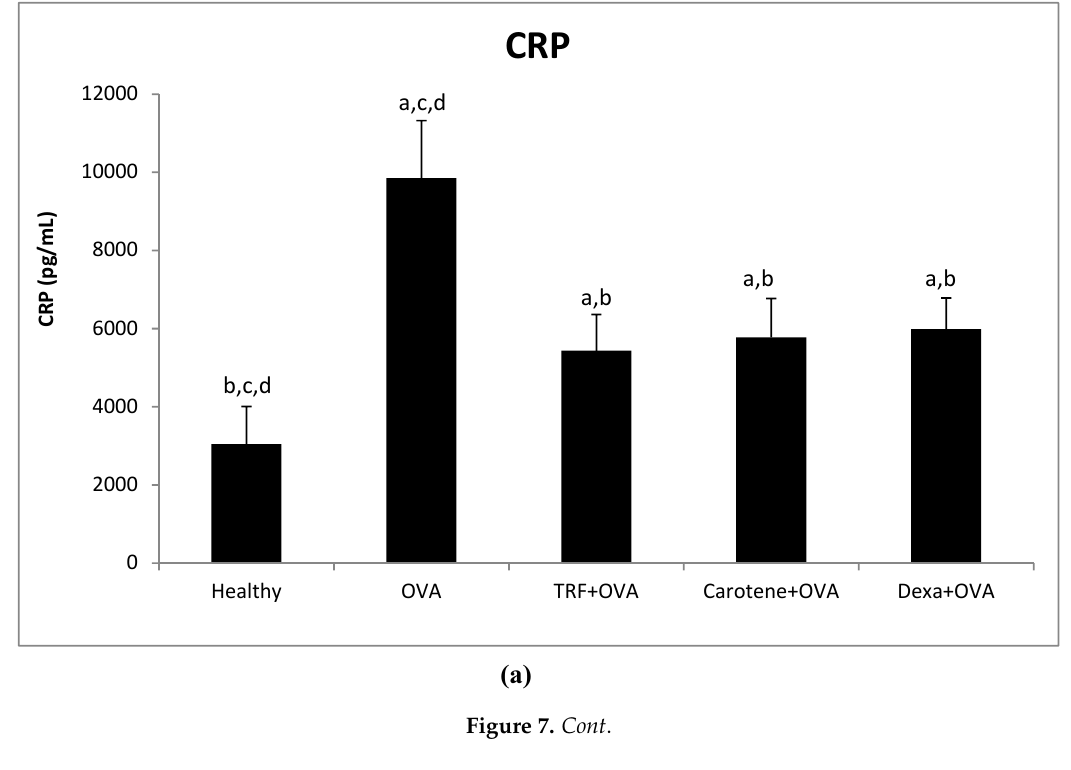
Int. J. Mol. Sci. 2019 , 20 , x FOR PEER REVIEW